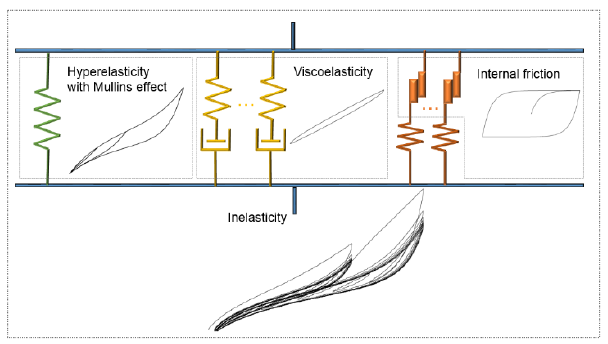
Figure 13. Rheological model of the inelasticity of